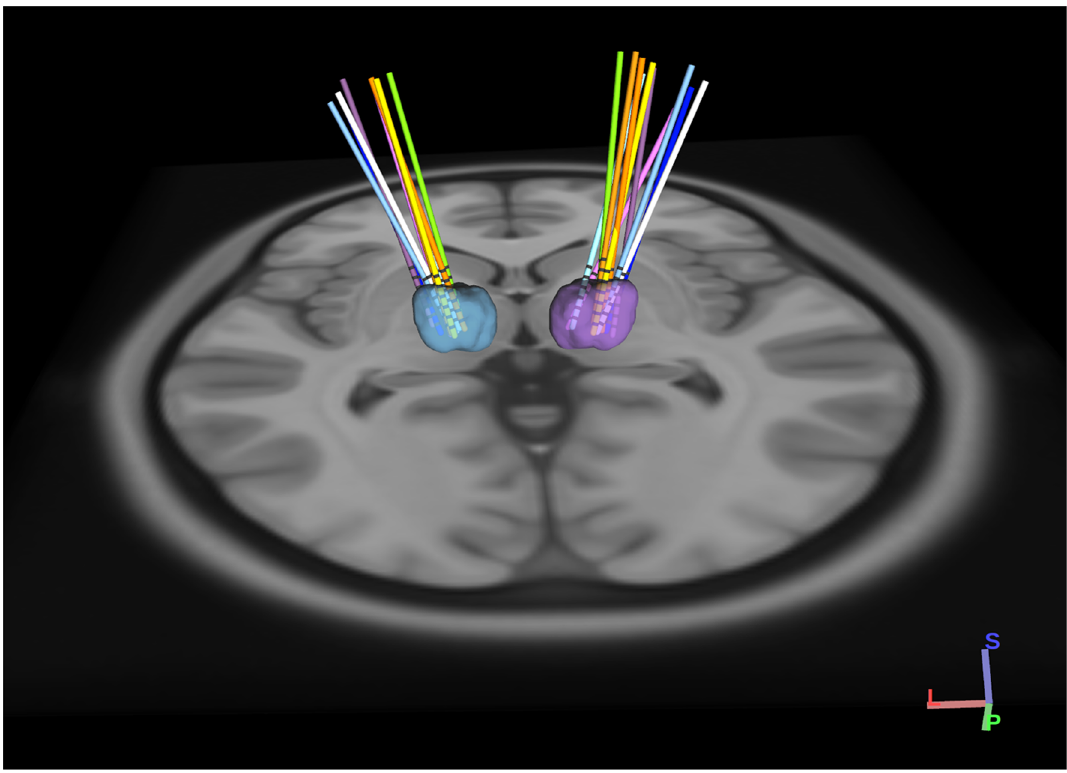
Figure 1. 3D rendering of group based DBS electrodes in the bilateral ventral intermediate nuclei. Axial view from normalized scans into MNI space. The VIM boundaries were defined by the DISTAL atlas. Each pair of DBS electrodes corresponds to a patient and are represented by a different color for each patient. A total of 20 DBS electrodes in 10 dystonic patients are represented through DSI Studio, V3 (http:// dsi- studio. labso lver.